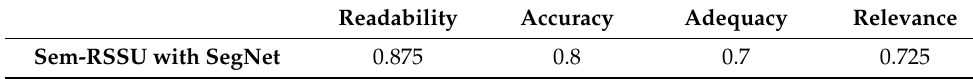
Table 3. Human Evaluation metrics for natural language scene description